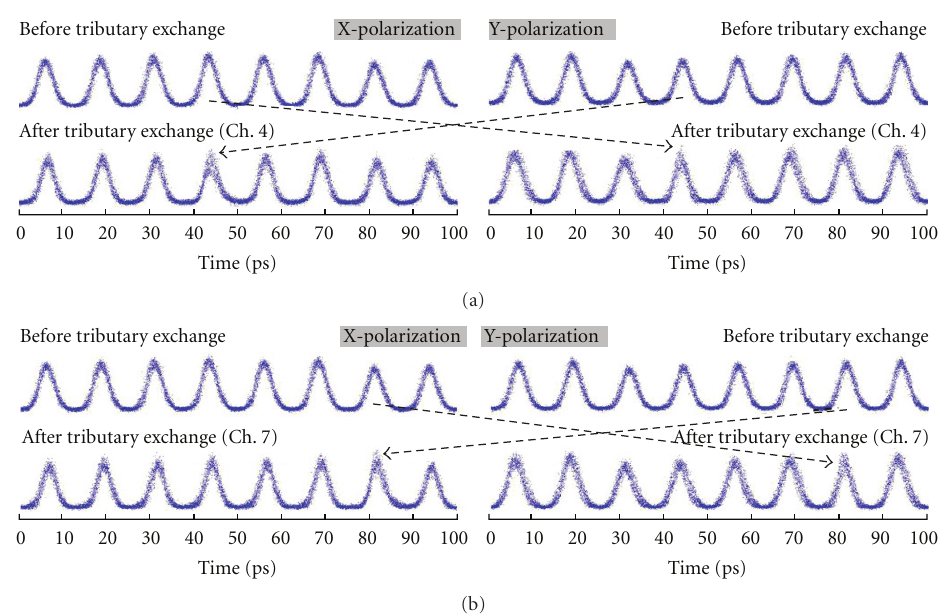
Figure 32: Eye diagrams of orthogonal tributary exchange of a 160 Gbit/s pol-muxed DPSK OTDM signal. (a) Ch. 4. (b) Ch. 7.